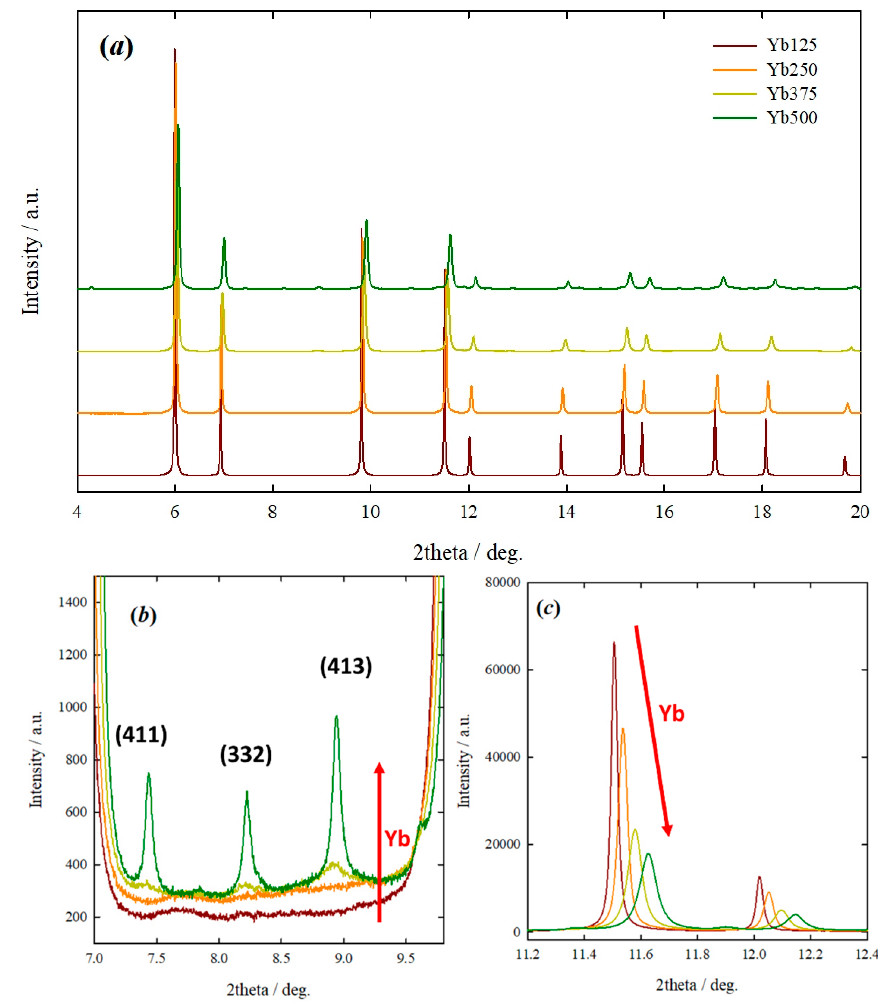
Figure 1. ( a ) Experimental synchrotron XRPD patterns as a function of Yb loading shifted along y -axis. Squares highlight angular region described in following panels. ( b ) Evidence for appearance of superstructure peaks (411), (332), and (413) by increasing Yb doping. ( c ) Example of (311) and (222) reflections (in fluorite setting).